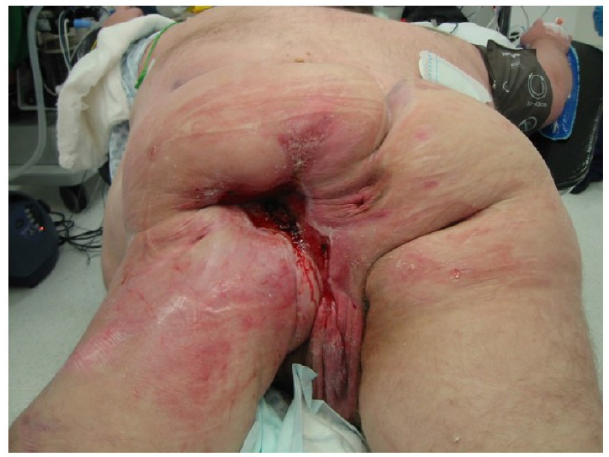
Figure 4. Patient with a longstanding pressure ulcer over the left ischium. At operation, this was found to have developed a squamous carcinoma.